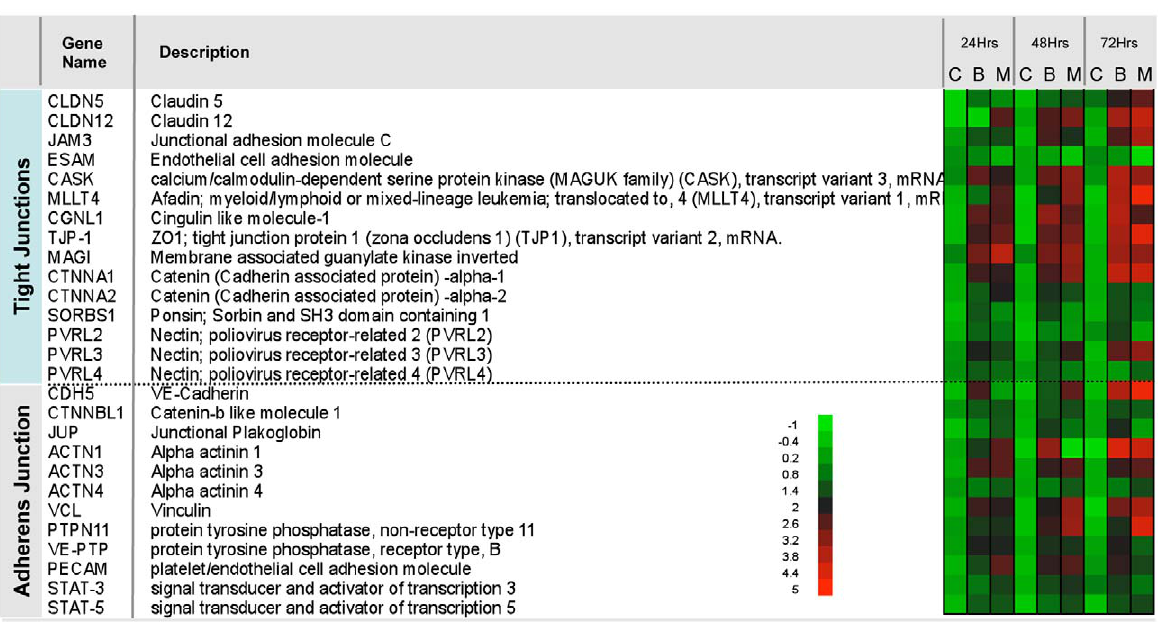
Figure 5. Expression of junction molecules by LEC by microarray analysis. Shown in the heat map are the relative expression levels of the genes listed in response to BmA (B) or MfAg (M) at 24-, 48-, and 72-h time points. The control values (C) are the relative expression levels of pooled controls at the time-points listed. The heat map scale is shown in the inset. doi:10.1371/journal.ppat.1000688.g005 PLoS Pathogens |